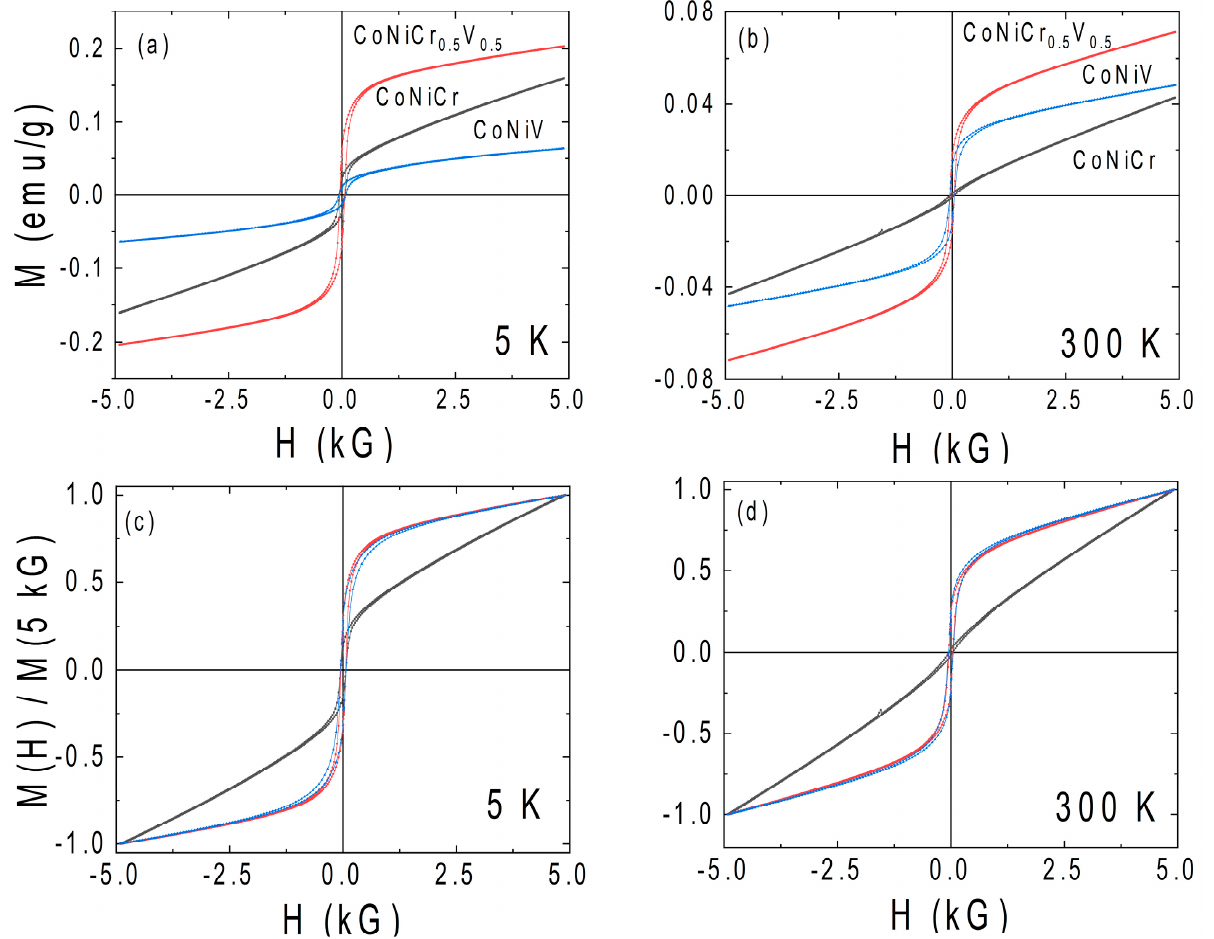
Figure 6. ( a , b ) The magnetic moment comparison of all samples for 5 K and 300 K. ( c , d ) The field dependence of the magnetization normalized to a magnetization value of 5 kG for the indicated